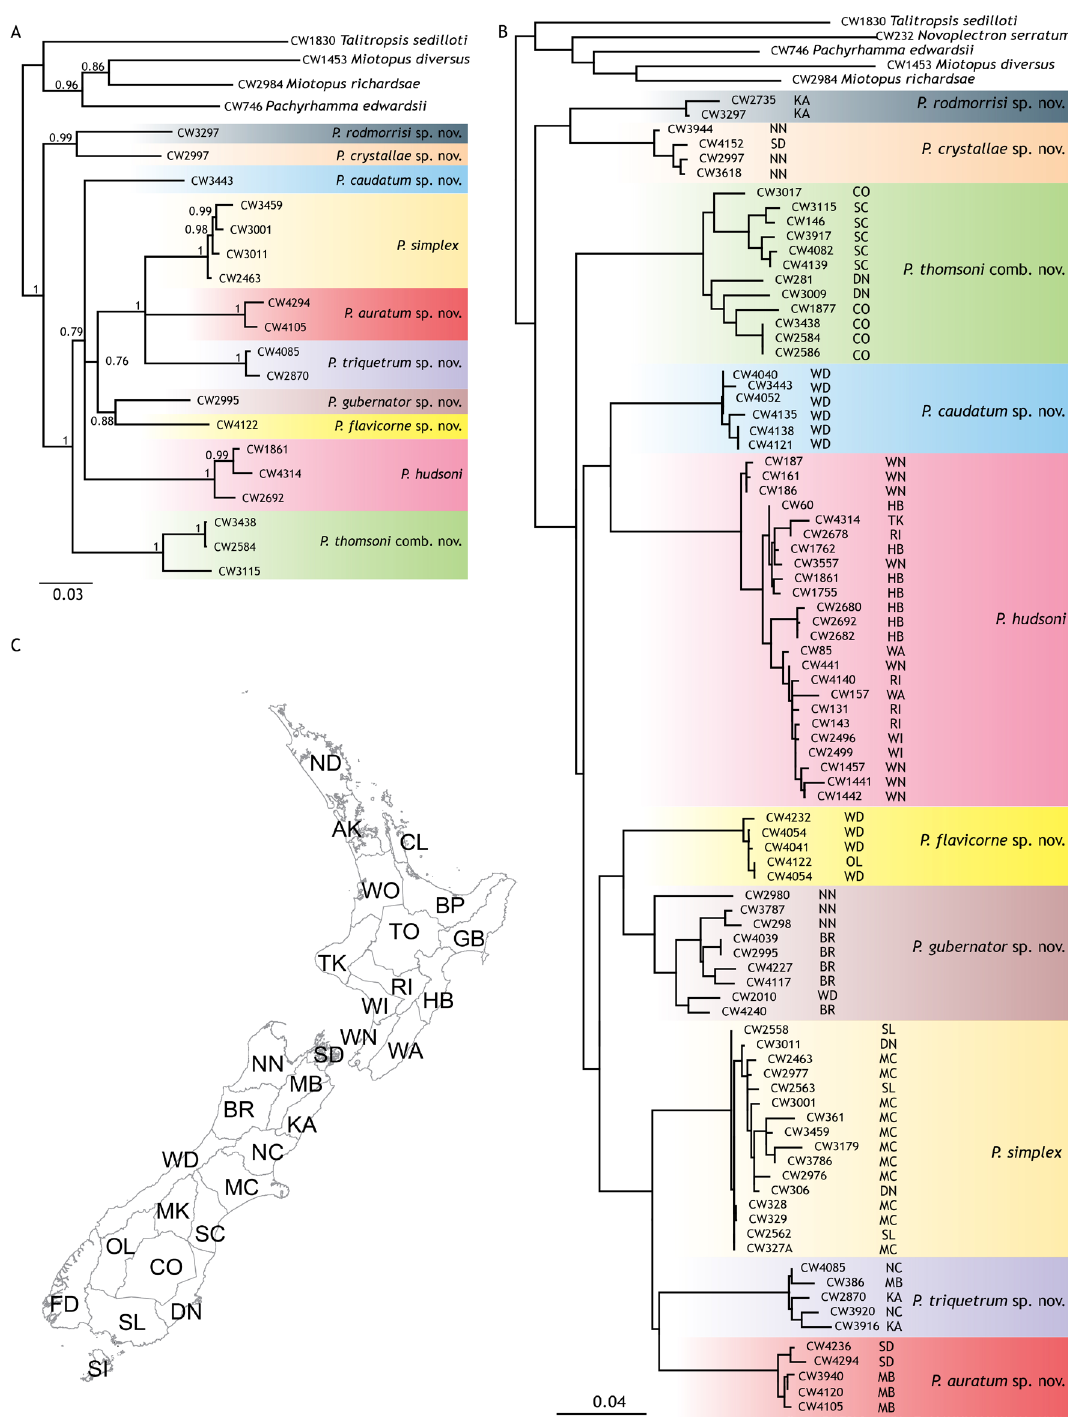
Fig. 2. Phylogenetic relationships of Pleioplectron Hutton, 1896 cave wētā based on mtDNA sequence. A . Bayesian analysis using a mtDNA sequence alignment of 1429 bp spanning the majority of COI, with a minimum individual sequence length of 1330. Posterior probabilities are shown by nodes. B . Maximum Likelihood tree using PhyML with a COI alignment that contained sequences ranging from 483bp to 1429 bp, although the majority were > 850 bp at the 3′ end of the gene. C . Map of New Zealand entomological (Crosby) regions. These codes are indicated in the Material examined section for each